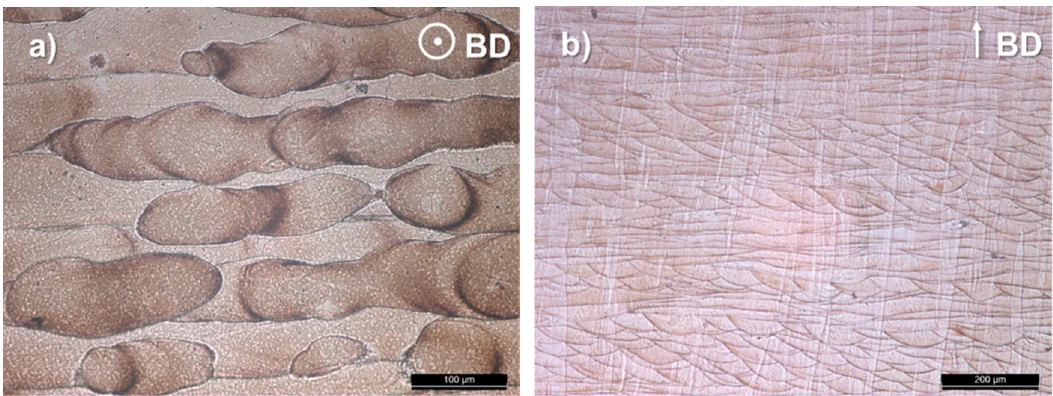
Figure 2. Top ( a ) and cross section ( b ) views of as-built β -Ti21S (optical microscope). BD, building direction.